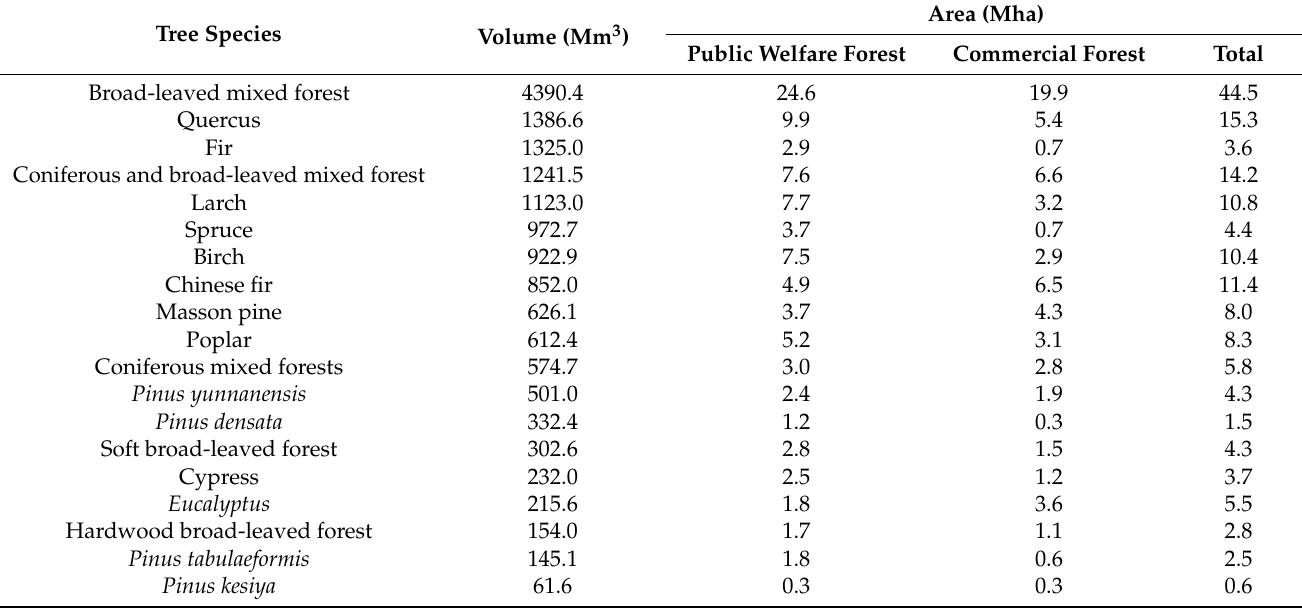
Table 1. Volume and area of dominant tree species of Chinese arbor forests in